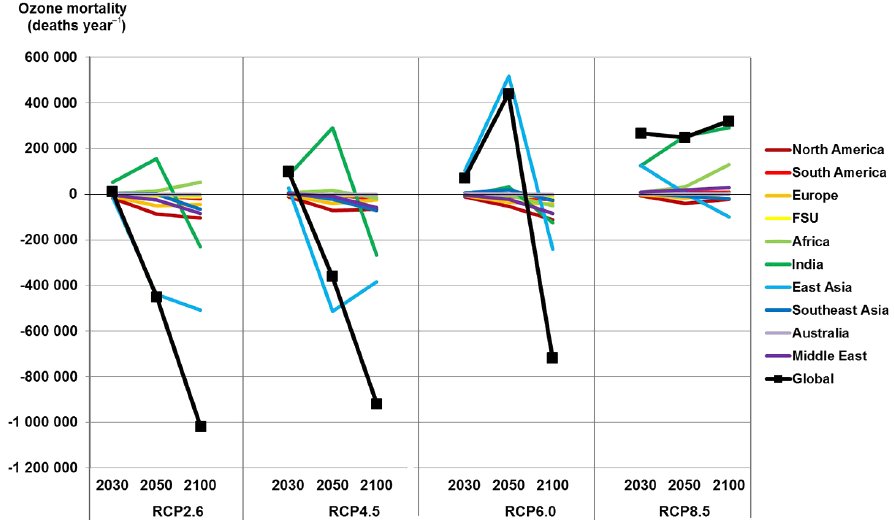
Figure 3. Future ozone respiratory mortality for all RCP scenarios in 2030, 2050 and 2100, showing the multi-model regional average (deathsyear − 1 ) in 10 world regions (Fig. S1) and globally, for future air pollutant concentrations relative to 2000